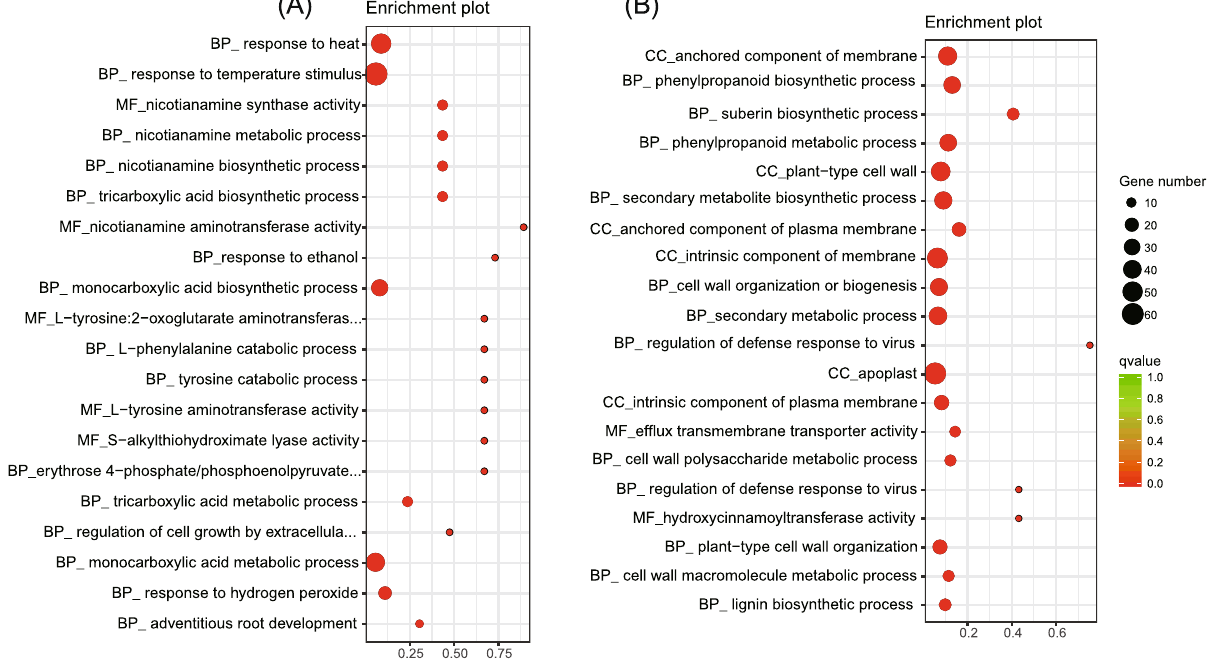
Figure 3. Analysis of GO enrichment for DEGs. ( A ) and ( B ) indicate GO enrichment for up- and down- regulated DEGs,